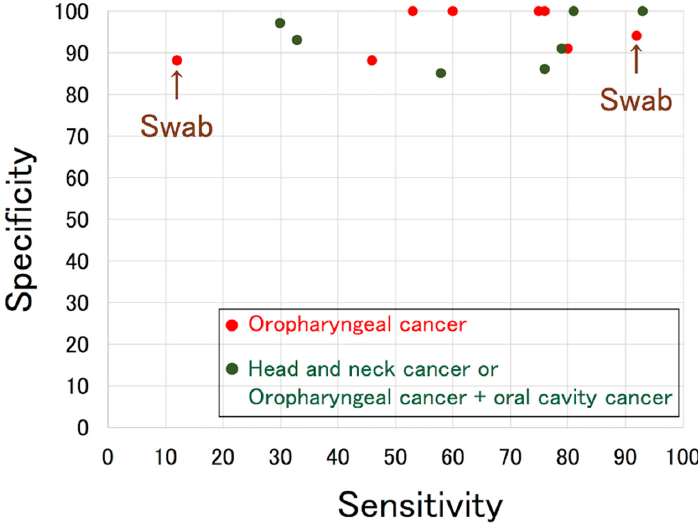
Figure 1. Scatter plot of sensitivity and specificity of pre-treatment HPV DNA detection in oral rinse in each study of oropharyngeal cancer. “Swab” indicates samples collected by swab. 5. Post-Treatment HPV DNA in Oral Rinse of Oropharyngeal Cancer Patients Residual plasma EBV DNA after the completion of initial treatment is associated with a poorer prognosis in NPC patients. Similarly, as mentioned before, residual plasma HPV DNA could be a predictive indicator of a poorer prognosis in HPV-associated OPC pa- tients. From a similar perspective, the dynamics of HPV DNA in oral rinses after treatment has been of marked interest. Chuang et al. reported that four of 20 patients with positive pre-treatment HPV DNA ultimately developed recurrence, and two of these four patients had HPV16-positive post-treatment salivary rinses, showing 50% sensitivity [48]. On the other hand, among 16 HPV16-positive patients who did not show recurrence, none had HPV16-positive salivary rinses after treatment, showing 100% specificity. Ahn et al. demonstrated that the sensitivity and specificity of pre-treatment HPV DNA detection in saliva in 83 OPC patients, including 72 HPV-positive and 11 HPV-neg- ative patients, were 53% and 100%, respectively [21]. Although the sensitivity seems to be relatively low compared with data from a systematic review by Gipson, they reported that four out of 38 OPC patients who were positive for pre-treatment HPV16 DNA had persis- tently detectable HPV16 DNA in their saliva after treatment [21,46]. In a multivariable analysis, a post-treatment saliva HPV-positive status was associated with a higher risk of recurrence (HR, 10.7; 95% CI, 2.36–48.50) ( p = 0.002). Overall survival was reduced among those with a post-treatment saliva HPV-positive status (HR, 25.9; 95% CI, 3.23–208.00; p = 0.002). Rettig et al. prospectively demonstrated that persistent HPV16 DNA was detected in oral rinse samples in five of 124 HPV-associated OPC patients, whereas it was detected in 67 of 124 patients in pre-treatment oral rinse samples [36]. Furthermore, patients with persistent HPV16 DNA after treatment showed significantly poorer progression-free sur- vival (HR, 29.7; 95% CI, 9.0–98.2; p < 0.001) and overall survival (HR, 23.5; 95% CI, 4.7– 116.9; p < 0.001) than patients without persistent HPV16 DNA. Although the prognosis was not stated, Yoshida et al. also demonstrated that persistent HPV DNA in oral rises was only detected in one of eight HPV-associated OPC patients without clinically residual disease after treatment [40]. These results suggest that detectable pre-treatment HPV DNA in oral rinses is cleared after treatment, and that persistent HPV DNA is associated with a poorer prognosis. A larger-scale prospective study was recently published by Fakhry et al. [45]. Of their 396 patients—including 170 (seven HPV-positive and 163 HPV-negative) with oral cancer,